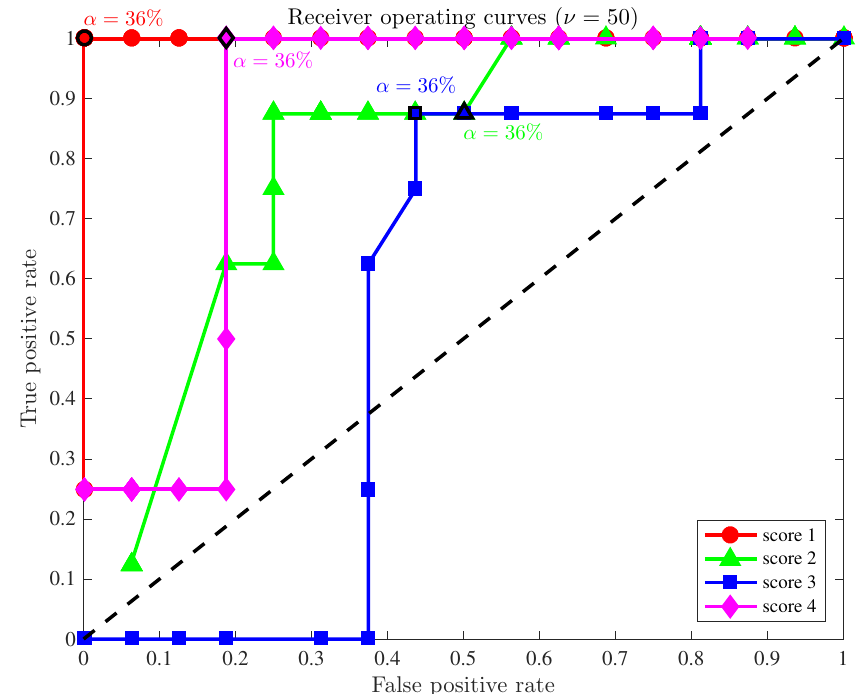
Figure 2. The receiver operating curves (ROCs) for the four scores when the size of the samples to diagnose is ν = 50 and the sensors used are numbers 1,2,4,5,6 and 7. The pair (false positive R 2 is emphasized—with a black border—for the four scores when the level of rate, sensitivity) ∈ significance is α =